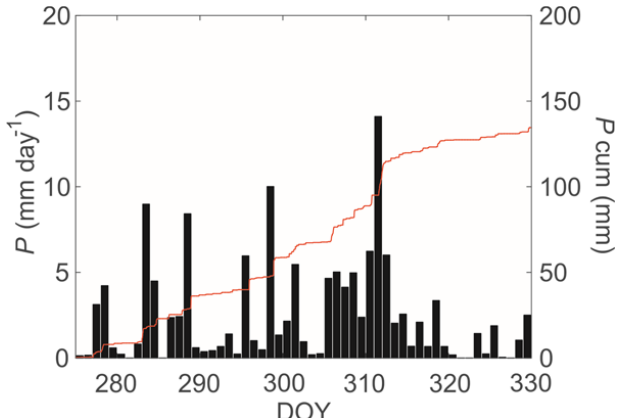
Figure 7. Daily ( P , mm day − 1 ) and cumulative ( P cum , mm) precipitation measured at the test site.